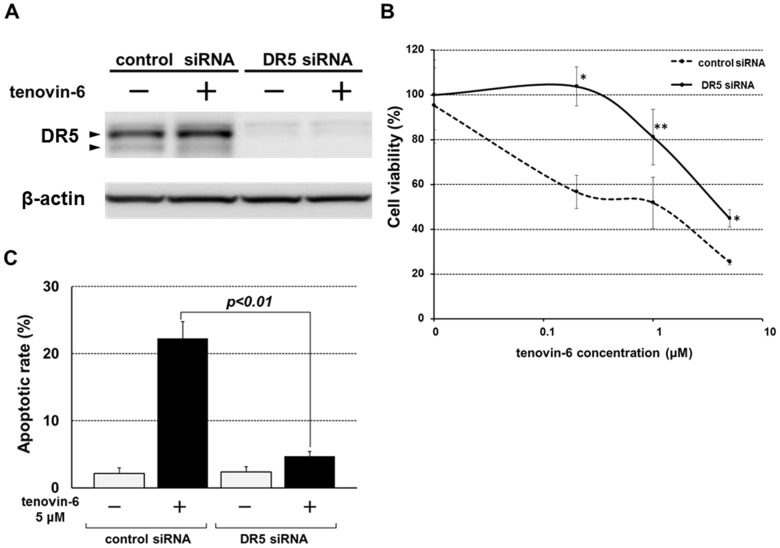
Effects of DR5 knockdown on cell survival and apoptosis in TP53-null KatoIII cells.A: KatoIII cells were transfected with 1 nM siRNA control or siRNA against DR5 mRNA. Forty-eight hours after transfection, the cells were treated with 5 µM tenovin-6 for 24 h. Western blotting showed the down-regulation of DR5 by siRNA transfection. A doublet of DR5 shows its precursor (upper band) and mature isoforms (lower band). B: Cells were transfected with 1nM siRNA control or DR5 siRNA for 48 h, treated with 0.2, 1, and 5 µM tenovin-6 for 72 h and then subjected to cell viability measurements by WST-8 assay. The statistical significance of differences between groups was evaluated using Student's t-test. * p<0.01; ** p<0.05. C: The effect of DR5 knockdown on tenovin-6 induced apoptosis was analyzed by flow cytometry using PI staining. The results are expressed as the mean ± SD. The statistical significance of differences between groups was evaluated using Student's t-test.